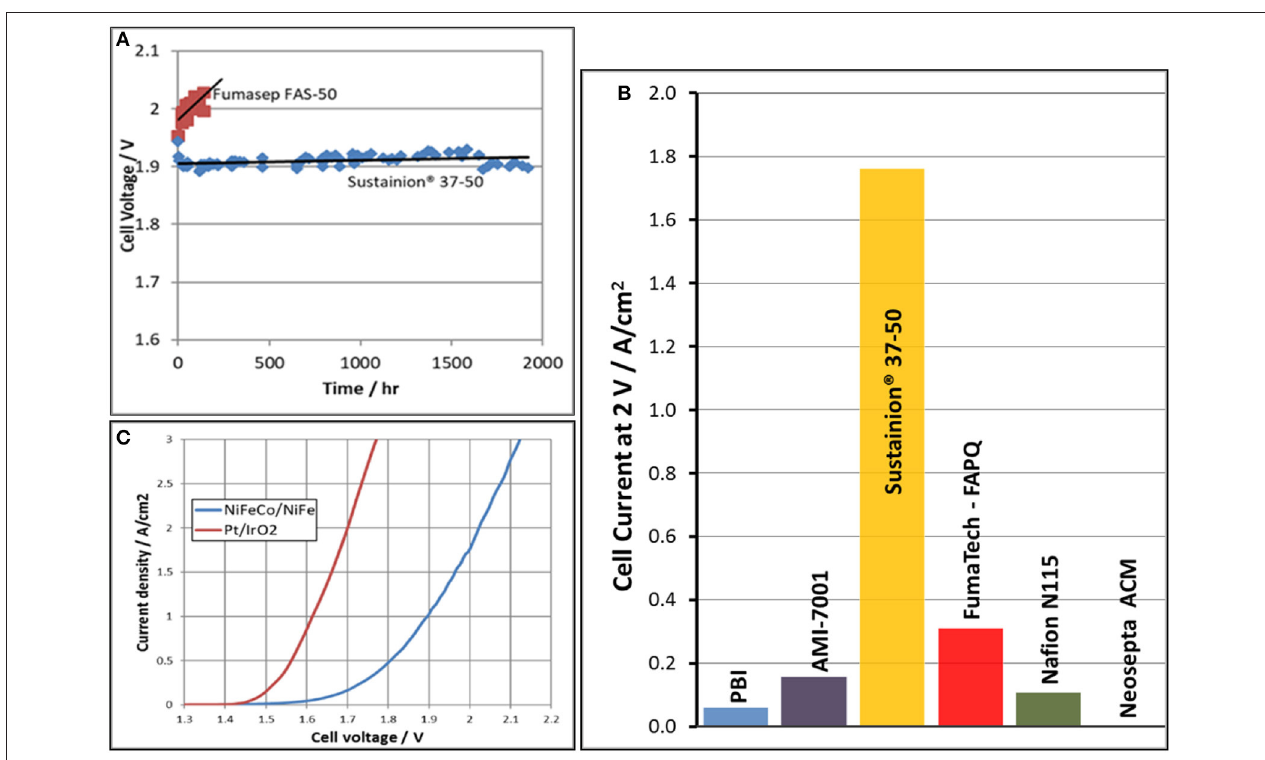
FIGURE 11 | Cell voltage as function of time comparison in cells evaluating a Sustainion ® 37-50 anion membrane and a Fumatech Fumasep ® FAS-50 anion exchange membrane in 1M KOH at 60 ◦ C is shown in (A) . The alkaline electrolysis cell current at an applied voltage of 2V for various membranes in 1M KOH at 60 ◦ C is shown in (B) . The polarization curves of the same cell comparing precious metal (Pt/IrO 2 ) electrode catalysts to base metal electrode catalysts (NiFeCo/NiFe) in 1M KOH at 60 ◦ C using a Sustainion ® 37-50 anion exchange membrane is shown in (C)